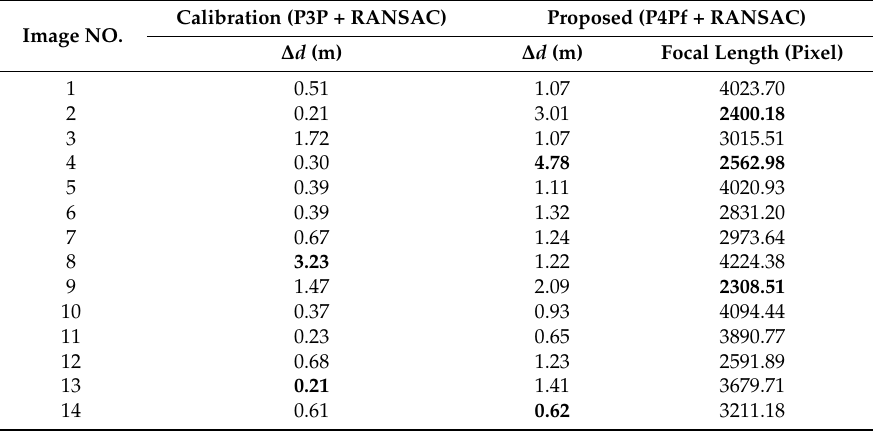
Table 6. The influence of camera calibration.